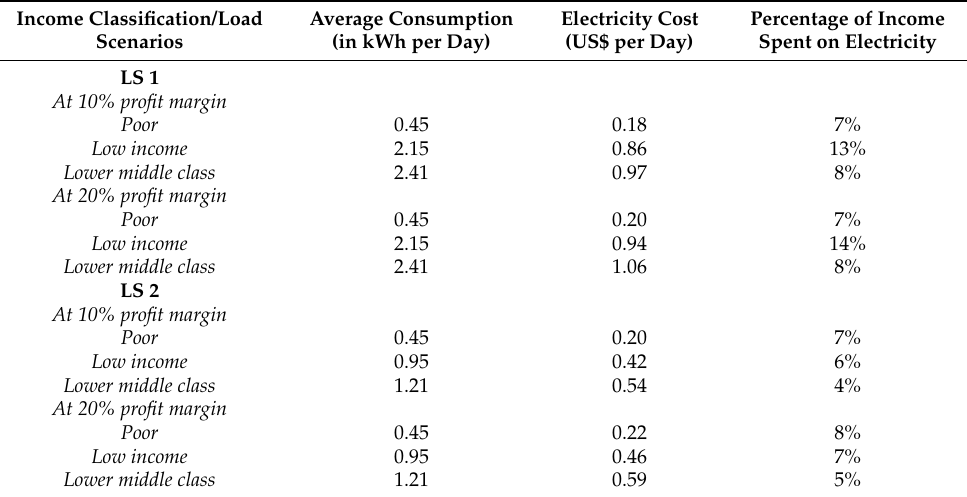
Figure 6. Actual electricity consumption for Gilutongan Island. Table 6. Capacity to pay per household per income classification